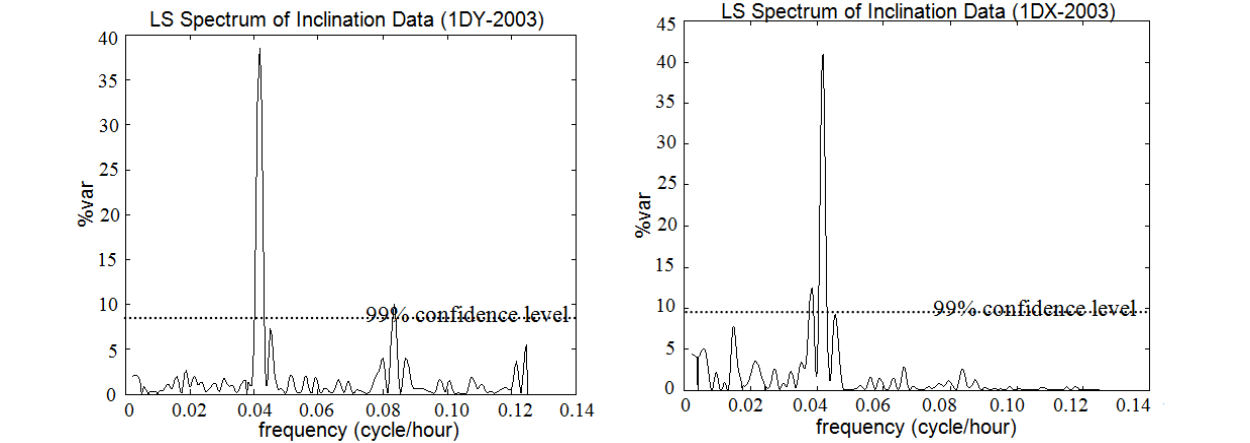
Figure 7. Least Squares (LS) spectrum of the entire observations .